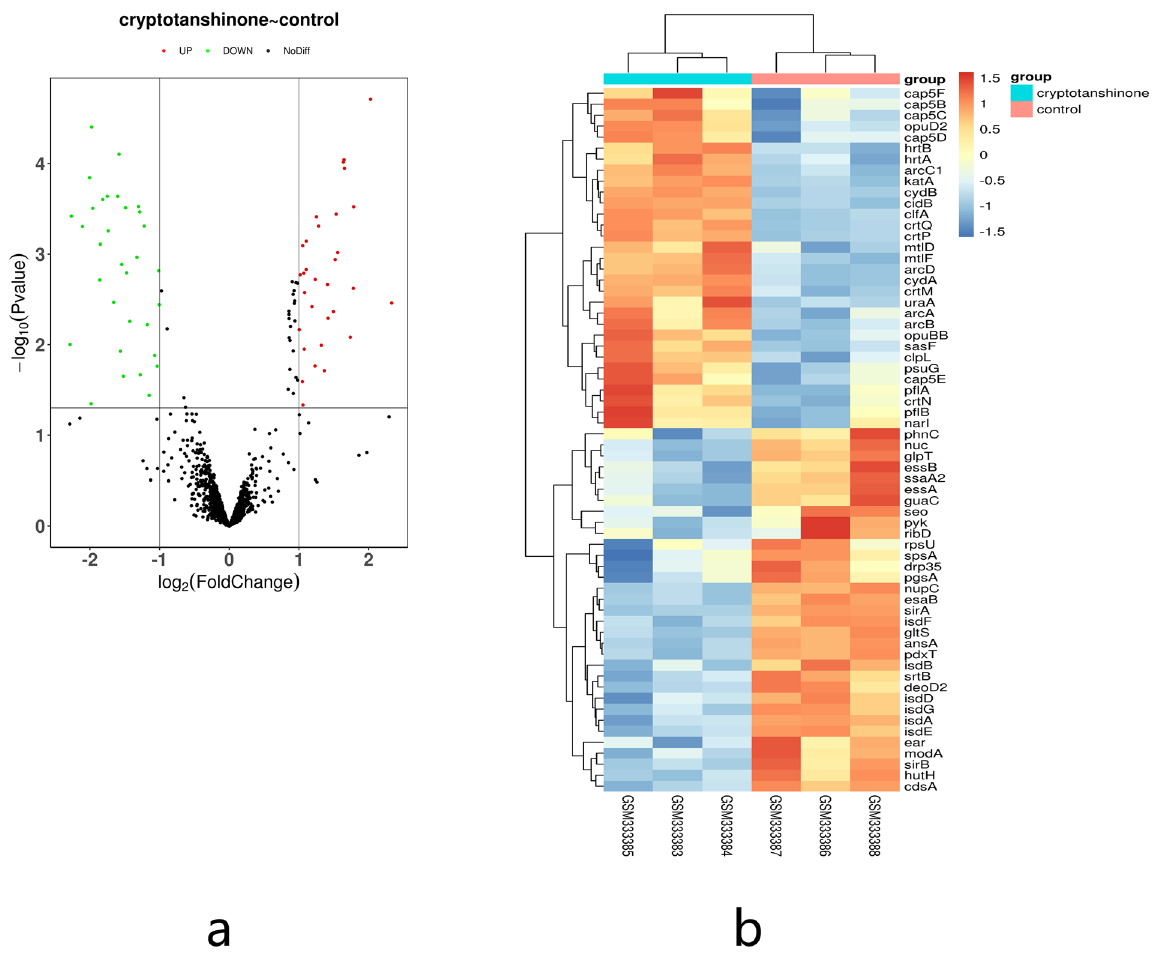
Figure 1. Screening of DEGs in MRSA induced by CT treatment: ( a ) volcano plots; and ( b ) hierarchical cluster analysis (heatmaps) of the common DEGs between CT treated samples and normal controls in GSE 13203. Statistically significant DEGs were defined with p < 0.05 and absolute log 2 FC > 1.0 as the cutoff